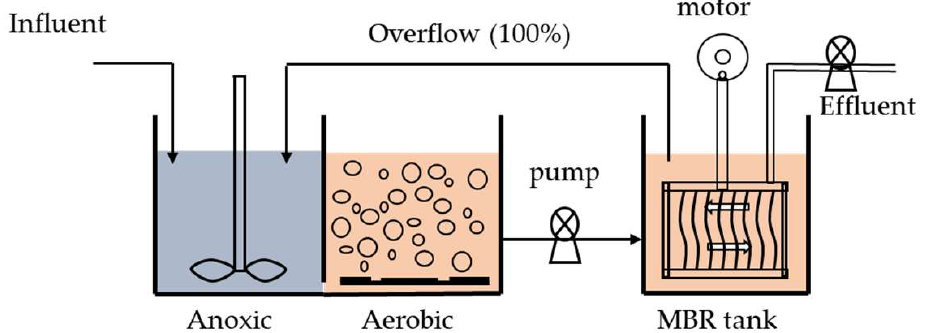
Figure 2. The schematic diagram of the pilot-scale LEP-N-MBR system.